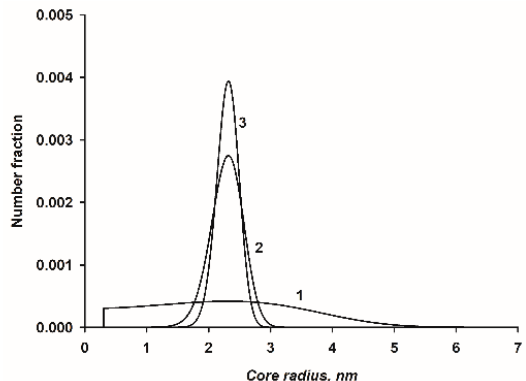
Figure 5. Three example size distribution curves of nanocluster complexes where the radius of the peak of the distribution was held constant and the product K seq a 0,1 was either 1.05, 3.65 or 10.0 in curves 1, 2, and 3, respectively. Parameters that were kept constant were, A CaP = 1.7 nm 2 , V CaP = 0.12 nm 3 , empirical chemical formula of the CaP: Ca(HPO 4 ) 0.4 (PO 4 ) 0.4 . The lower bound of the distributions, as clearly shown in curve 1 is the radius of the core formed from a single molecule of CaP ( k = 1). Curve 2 is a narrow distribution that describes the size distribution of CaP nanoclusters sequestered by β -casein 1–25, as discussed in Section 4.1.